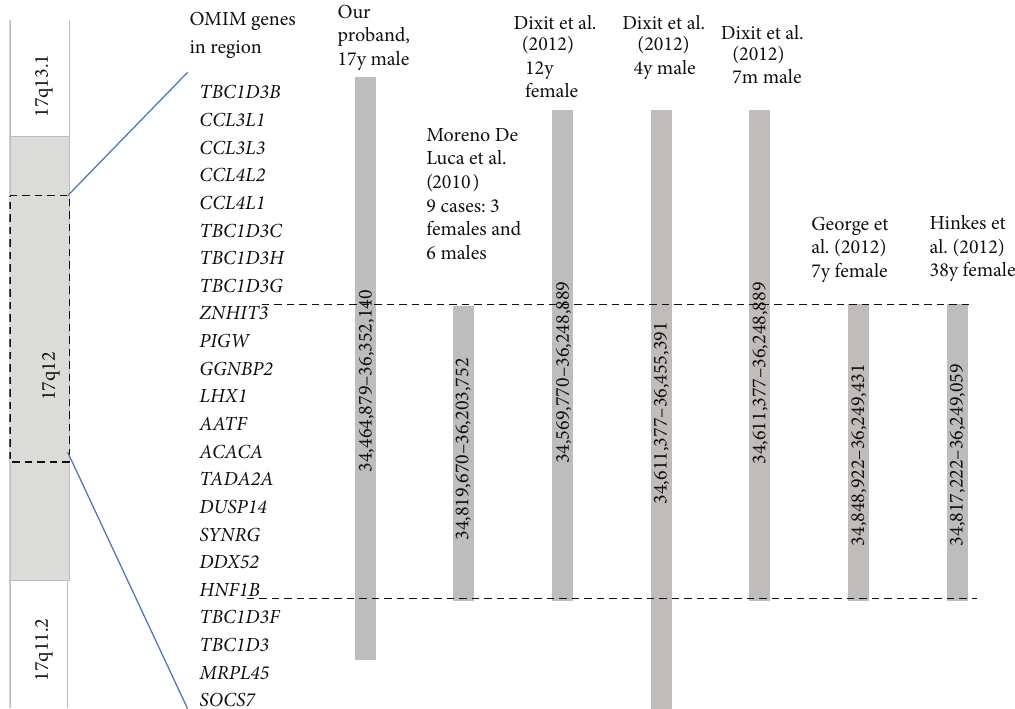
Figure 4: Comparison of deleted regions of 17q12. Dashed lines show the genes involved in the 17q11.2 deletion which are shared by all 7 cases. All genomic coordinates were converted to GRCh37/hg19 for